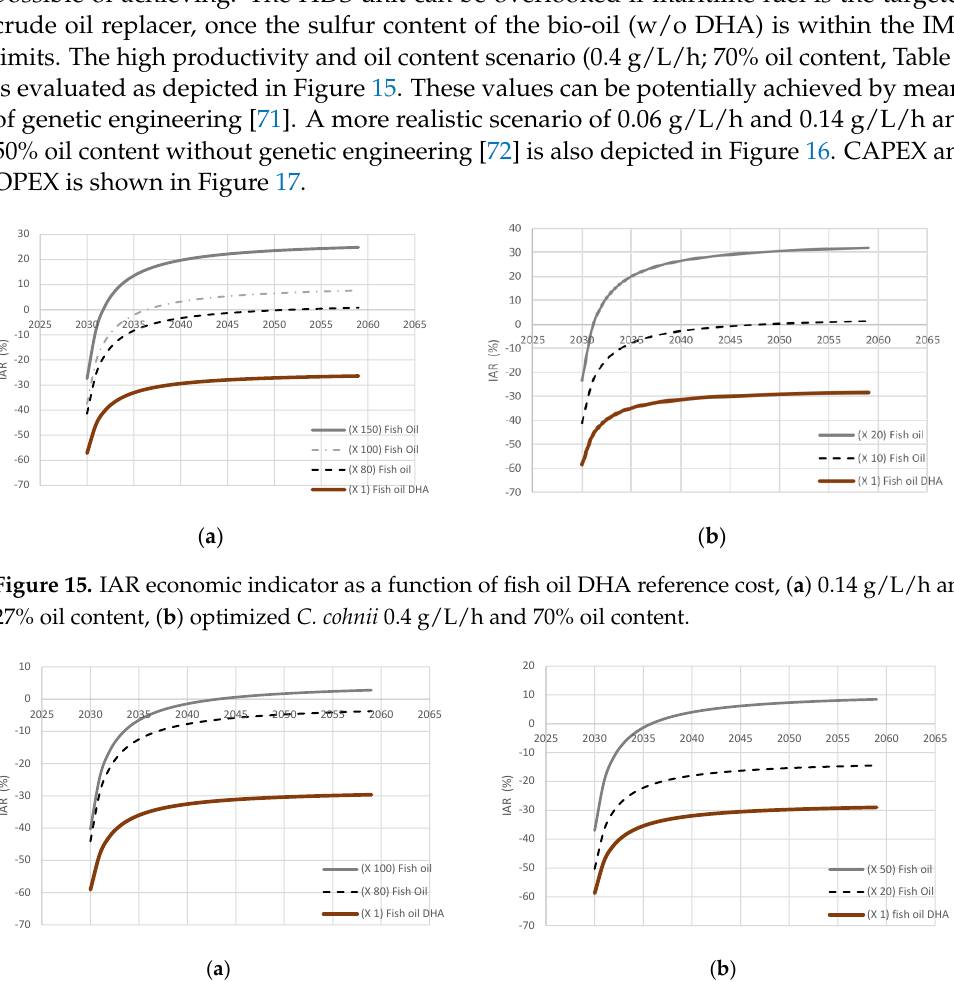
Table 5. Selected emission factors for N-fertilizer, jet fuel, DHA, and district heating from a C. cohnii biorefinery.